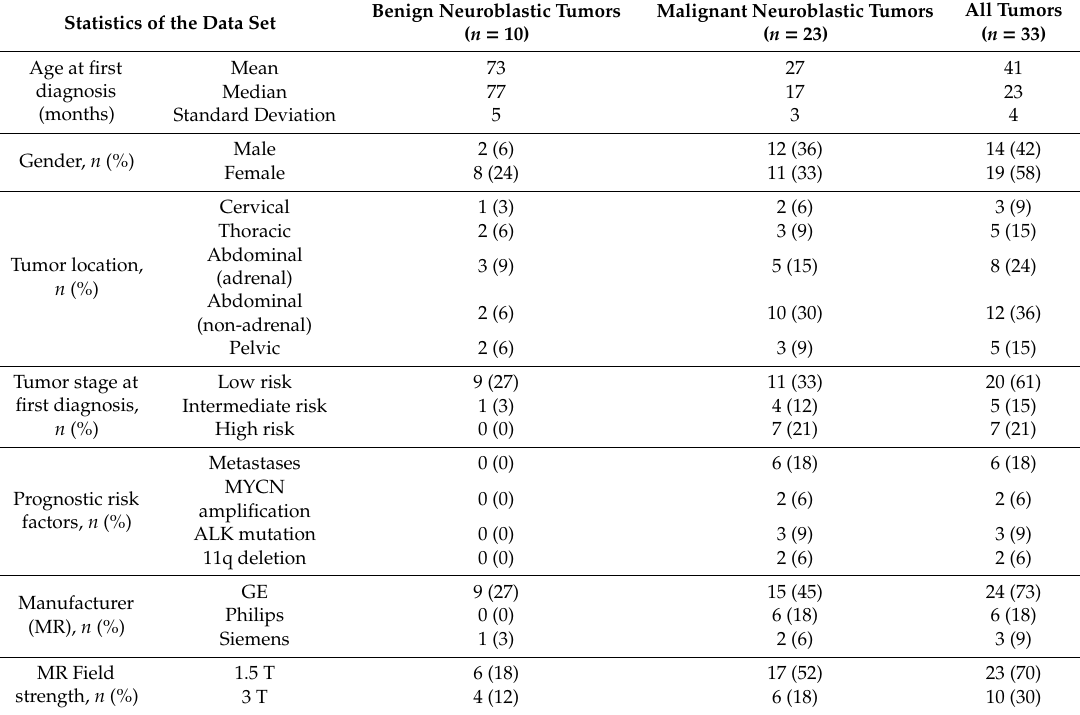
Table 1. Descriptive statistics of the cohort in terms of tumor malignancy. The cohort includes 33 consecutive pediatric oncology patients in the hospital oncological register from 2010 to 2020. All Tumors Benign Neuroblastic Tumors Malignant Neuroblastic Tumors Statistics of the Data Set ( n = ( n = 10) ( n = 23)